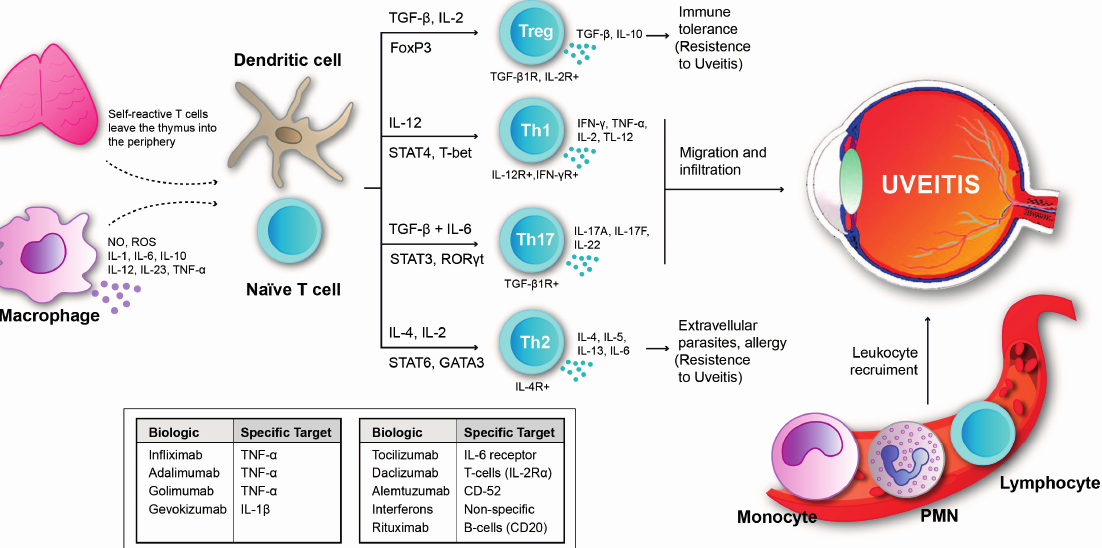
IL-13, mediate for humoural immune responses. However, a third subset of T helper cells, called Th17 cells, was discovered and characterized 10 years ago [15,16]. Thus inflammatory components include Th1 and Th17 lymphocytes that produce pro-inflammatory cytokines such as IL-2, INF- γ , IL-17, IL-23 and TNF α , which recruit leukocytes from circulation to result in tissue damage (Figure 1). Experimental uveitis disease induction has been characterized by the polarization of early T helper (Th) 0 or Th2-like responses to Th1 and Th17, whereas resistance to disease is associated with both regulatory cells and polarisation towards a Th2 pathway [17–19].